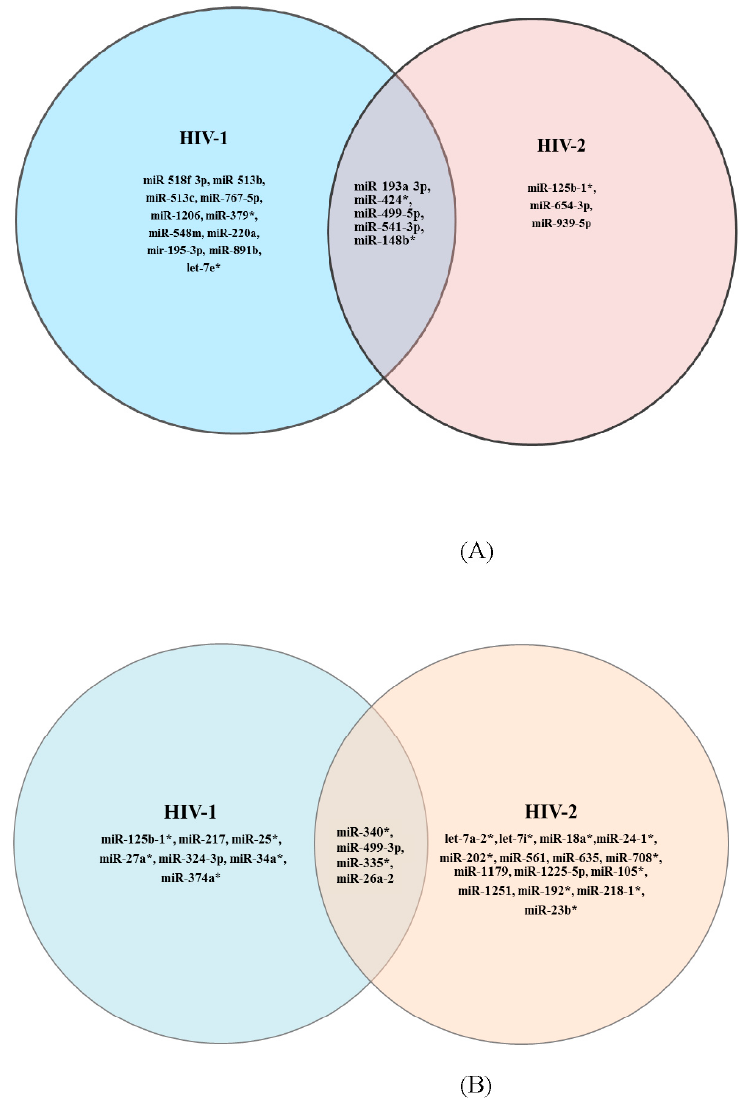
Figure 2. Venn diagram of differentially expressed miRNAs generated from QIAGEN web-based PCR-array data analysis software illustrating the overlap of upregulated or down regulated miRNAs between HIV-1 infected PBMC vs. control and HIV-2 infected PBMC vs. control. ( A ) Sixteen miRNAs showed greater than 2 fold upregulation in HIV-1 infected PBMC, whereas eight miRNAs showed upregulation in HIV-2 infected PBMC. Five miRNAs (miR-193a-3p, miR-424*, miR-499-5p, miR-541-3p and miR-148b*) were commonly upregulated in both HIV-1 and HIV-2 infected PBMC; ( B ) Eleven miRNAs demonstrated less than 2 fold downregulation in HIV-1 infected PBMC cells and nineteen miRNAs demonstrated less than 2 fold downregulation in HIV-2 infected PBMC cells respectively. Only four miRNAs (miR-340*, miR-499-3p, miR-335* and miR-26a-2) were commonly downregulated in both HIV-1 and HIV-2 infected PBMC